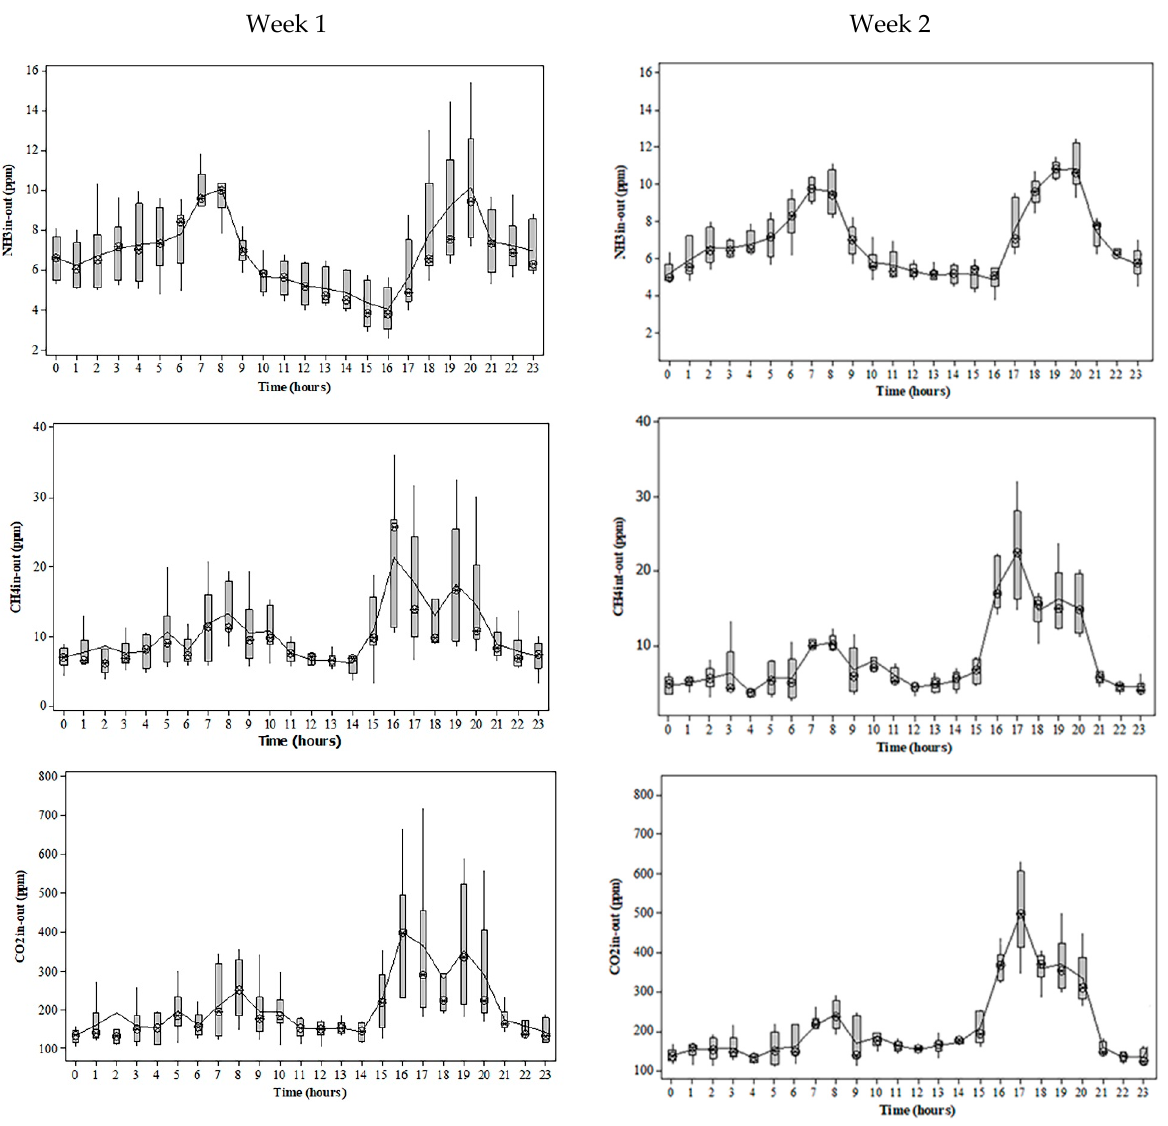
Figure 3. Daily difference between indoor and outdoor gas concentrations of gas pollutants (i.e., NH 3 and CH 4 ) and tracer gas (i.e., CO 2 ) during W1 and W2.